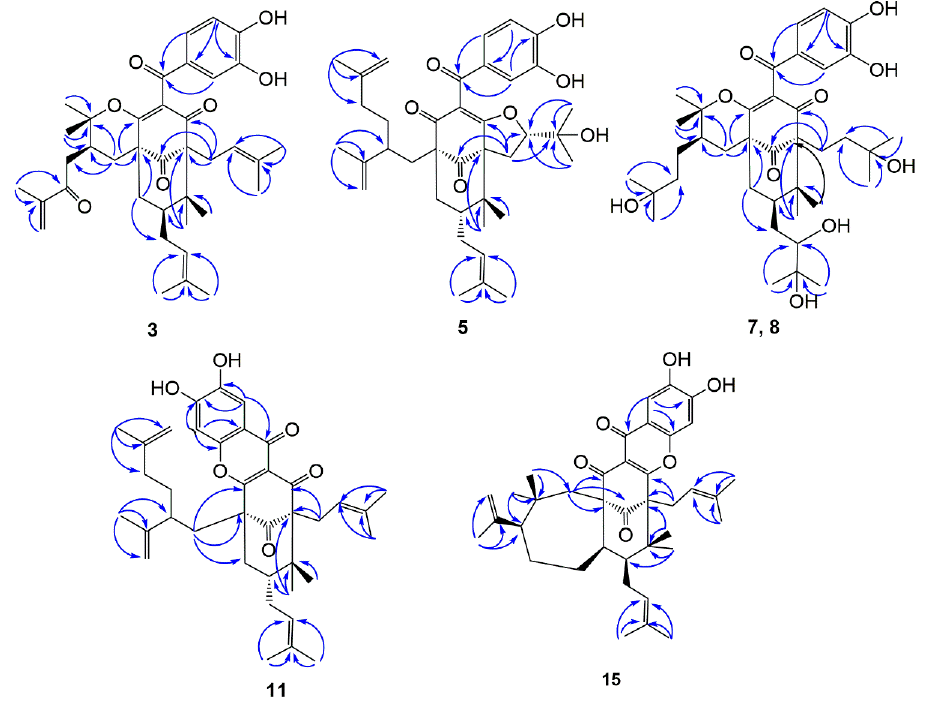
Figure 2. Key HMBC correlations of compounds 3 , 5 , 7 – 8 , 11 , and 15